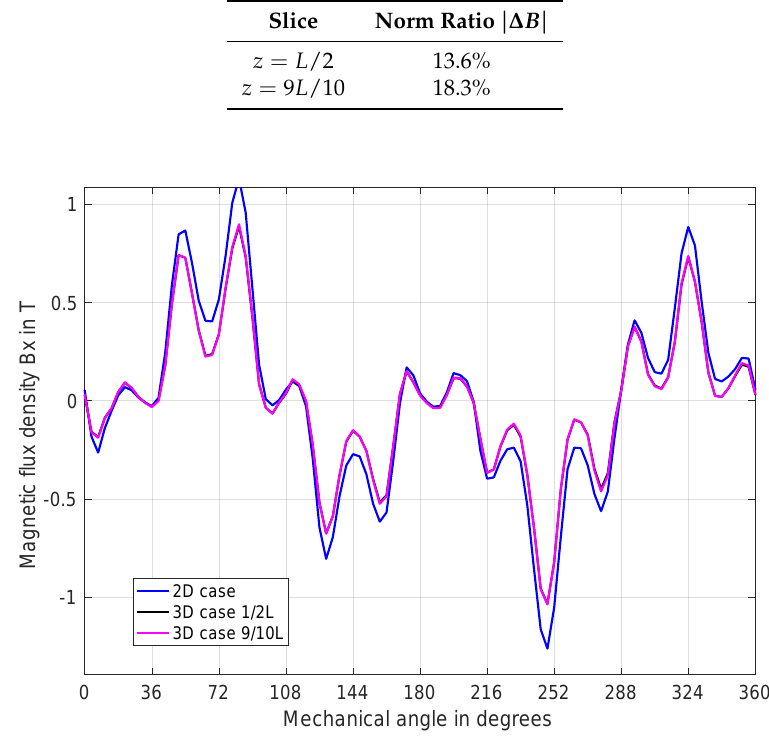
Figure 2. Example of magnetic flux density norm and eddy current arrow plot resulting from 3D simulation. Since there is not a common periodicity between the three rotors of the machine, the whole geometry needs to be modeled. Table 1. Flux density norm comparison between 3D and 2D simulations.